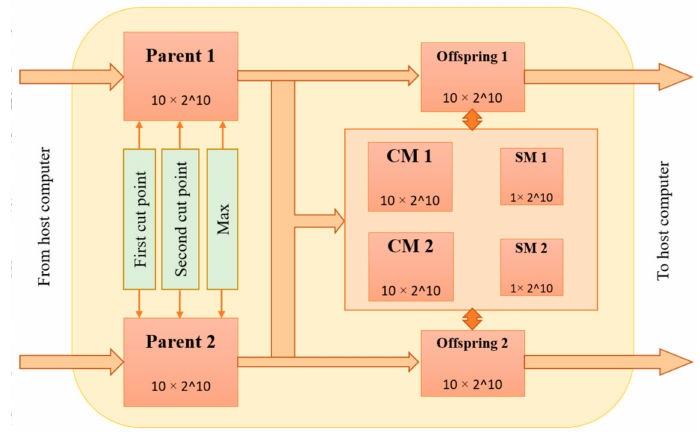
Figure 3. The proposed architecture for realizing the crossover operation in [5].